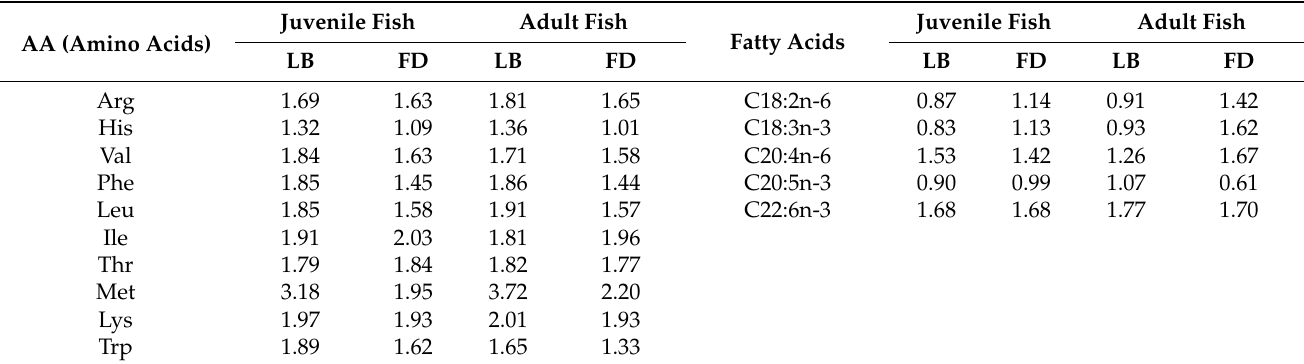
Table 6. Relative retention rate of dietary PUFA and EAA in the muscle of Siniperca chuatsi fed with live baits and formulated diet at different growth